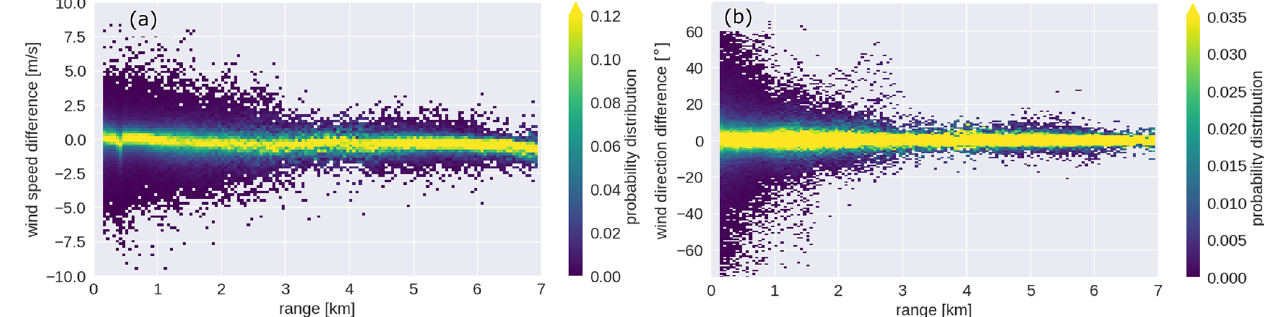
Figure 12. Two-dimensional probability distribution of the wind speed (panel a ) and direction (panel b ) differences stratified with height.